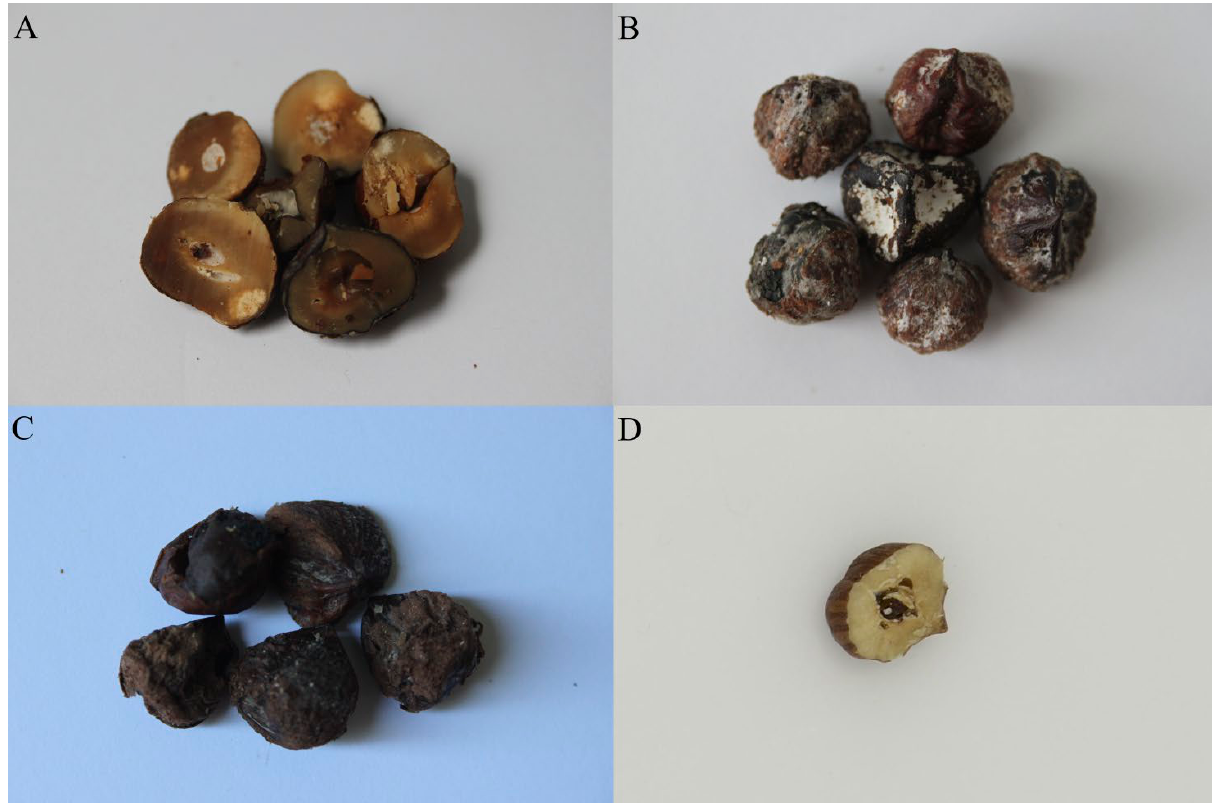
Figure 2. Symptoms observed in hazelnut kernels described as necrotic spots (A), mouldy (B), or black rotted (C), and vis- ible after nuts were cut